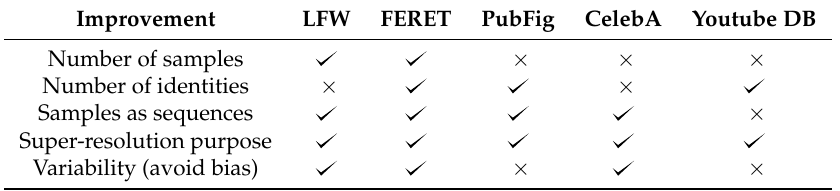
Table 1. The improvements of the proposed database in contrast to well-known training